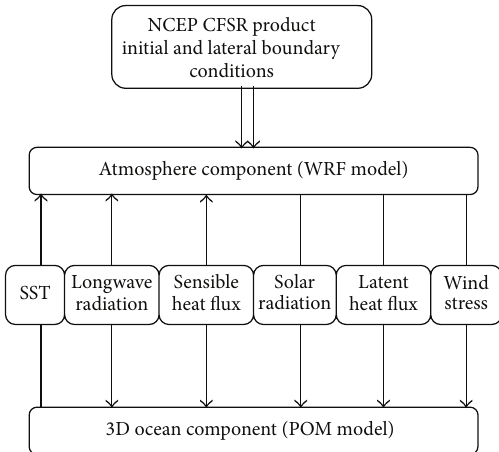
Figure 1: The schematic illustration of the coupled atmosphere-lake